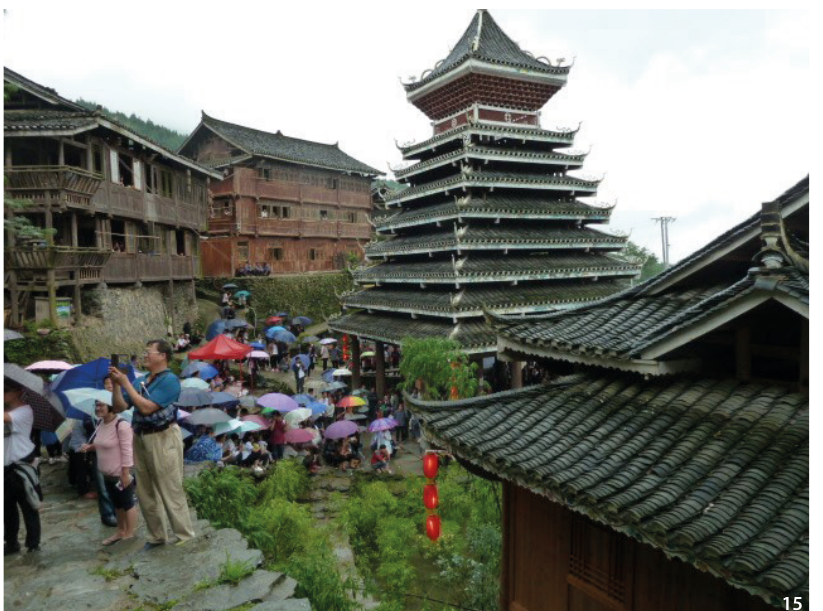
Figure 15 Tang'an Dong Village Drum Tower 15 and opera stage 2017 (Source: the